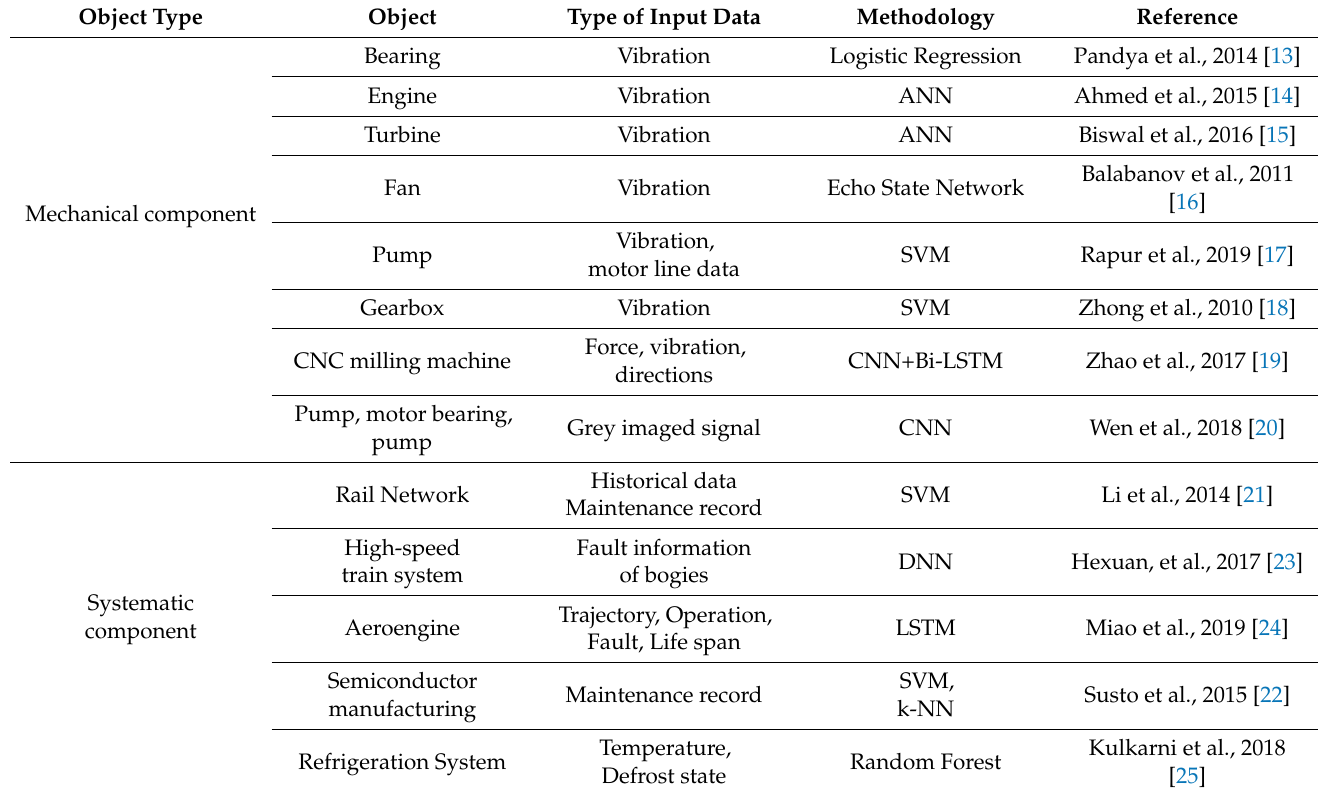
Table 2. Summary of exiting methods for predictive